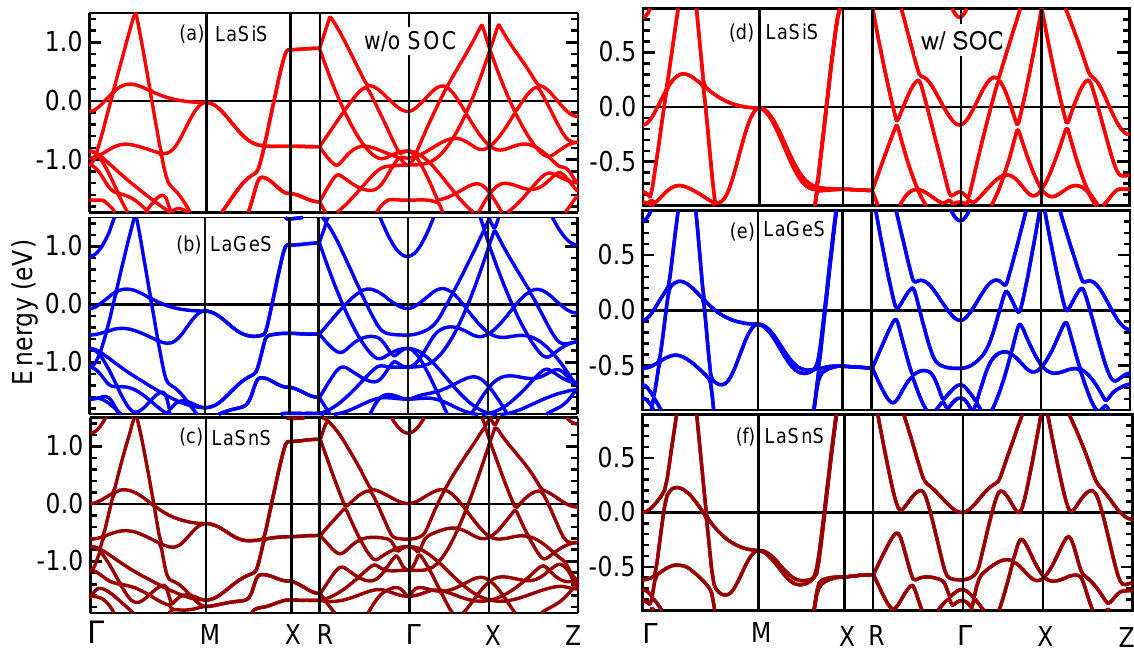
Figure 4. (Color online) Calculated electronic band structures of La X S ( X = Si, Ge, Sn) with and without SOC effect. Panel ( a – c ) represents band structures without SOC effect for La X S compound in red (Si), blue (Ge) and brown (Sn) solid lines, respectively. Panel ( d – f ) displays the band structures with SOC effect for La X S compounds by using the same colors lines as above. The same high symmetry k-path are used as Figure 2 to calculate band structures of La X S. The solid black line at zero indicates the Fermi